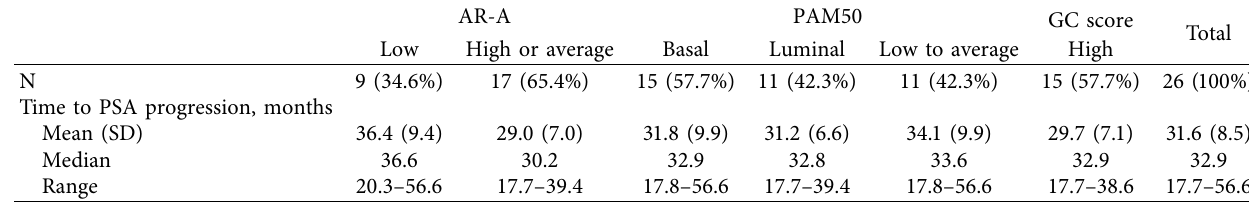
Table 6: PSA progression in patients with various molecular